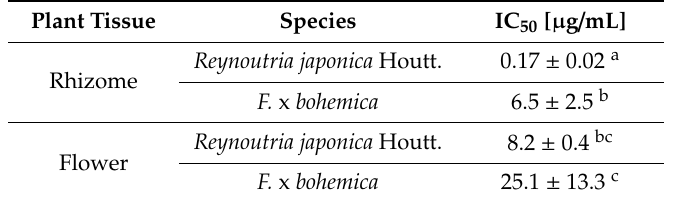
Table 2. The concentrations [ µ g / mL] that halved the α -amylase activity (IC 50